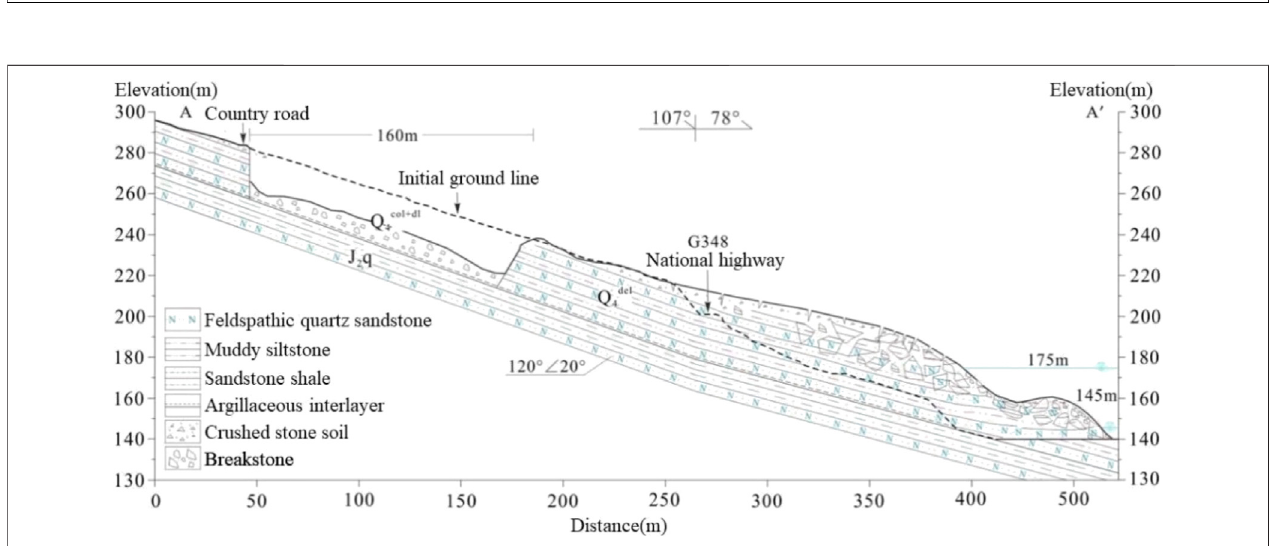
FIGURE3| Engineeringgeologicalplaneandzoningmapoflandslide.1,Themainrockslidingzone(I);2,tractivezone(II);3,tractivezone(III); 4,unloadingarea;5, landslide formation; 6, Middle Jurassic Qianfoya formation; 7, boundary of the landslide; 8, attitude of strata; 9, fractures; 10, sliding direction; 11, longitudinal section trace; 12, the lowest water level; 13, water level on the day of the event; and 14, the highest water level.